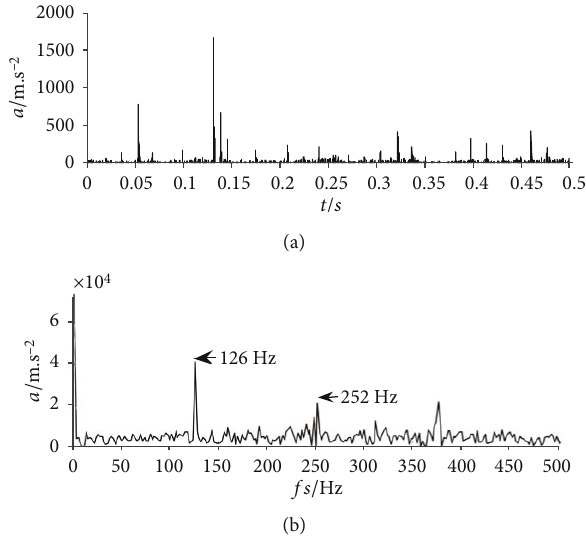
Figure 12: Waveform and frequency spectrum of bearing R an outer ring defect signal denoised by ASVD. (a) Waveform. (b) Frequency spectrum.